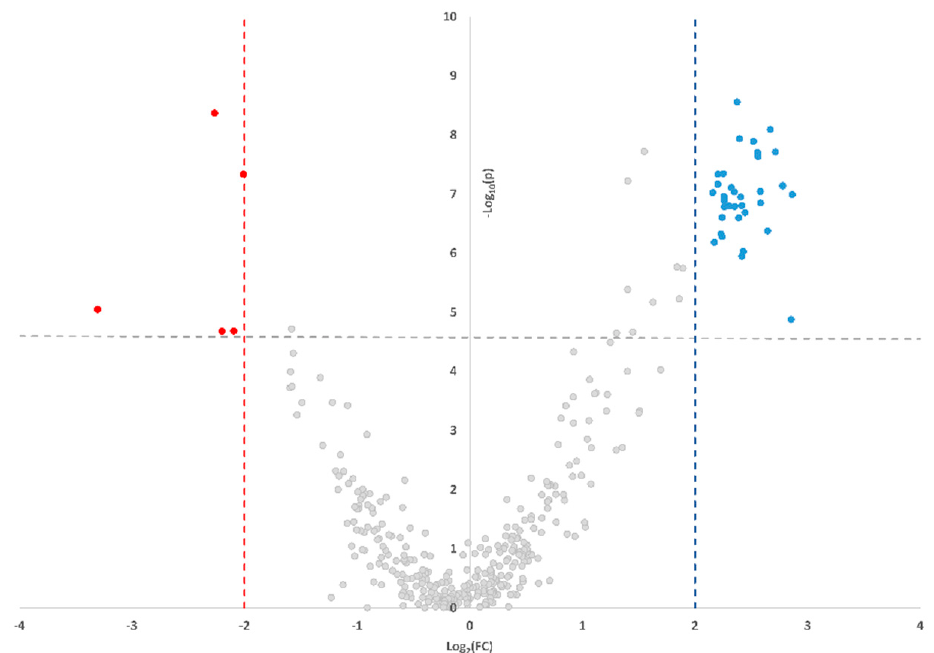
Figure 2. Smile plot reporting the features’ values change between HTN and NC patients. Red dots indicate features reduced in HTN, while blue dots indicate features increased in HTN. Table 2. Radiomics’ features selected with Boruta algorithm. HTN: patients with history of hy- pertension; NC: controls; Geo: Geometry features; DifEntrp: Difference Entropy; RLNonUni: Run Length Non-Uniformity; GrNonZeros: Percentage of Pixels with Nonzero Gradient; WavEnLH: Wavelet Energy. Table 3. Diagnostic performance of each classification model and of the ensemble. Results are ex- pressed as value ± standard error.